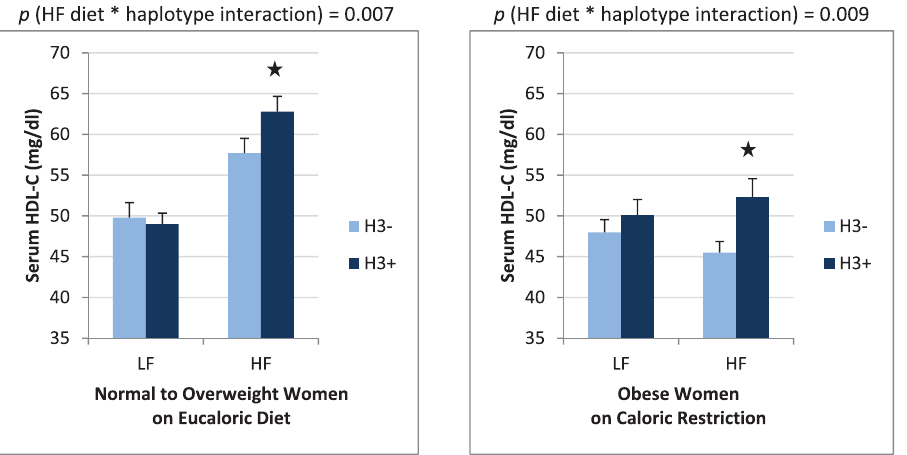
Figure 2. Effect of H3 haplotype on serum HDL-cholesterol levels in women. Values shown are mean + standard error. In normal to overweight females, changing from low fat (LF) to high fat (HF) diet increased HDL-C from 49.0 6 8.0 mg/dl to 62.8 6 11.2 mg/dl in H3 haplotype carriers and from 49.8 6 10.9 mg/dl to 57.7 6 10.9 mg/dl in H3 non-carriers. In obese females, calorically restricted ( 2 15% kcal) HF diet increased HDL- C from 50.11 6 11.60 mg/dl to 52.29 6 10.38 mg/dl in H3 haplotype carriers and decreased HDL-C from 47.99 6 12.90 mg/dl to 45.49 6 8.95 mg/dl in H3 non-carriers.